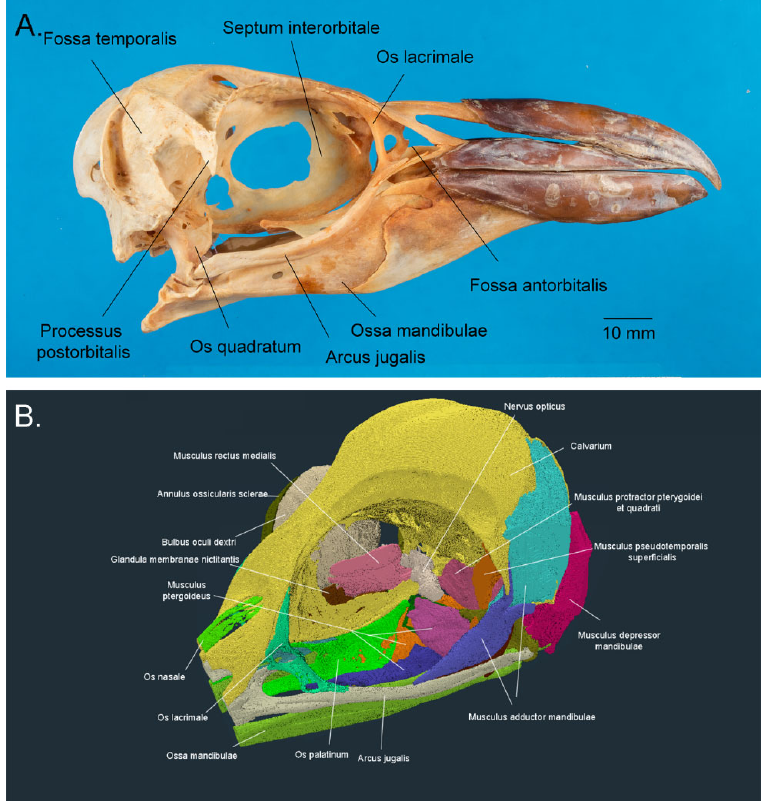
Figure 3. The orbit and ocular adnexae. ( A ) Skull of the Fiordland crested penguin Eudyptes pachyrhynchus , with the bony elements that border Orbita (the orbit) labelled (specimen AV1178, Otago Museum, Dunedin, New Zealand; Credit: Dane A. Gerneke, University of Auckland); ( B ) The orbital region of the little penguin Eudyptula minor , demonstrating the bones, muscles, and glands that surround Bulbus oculi (the eye). Reconstructed from publicly available raw data at https://figshare.com/search?q=10.17608/k6.auckland.c.5599341 accessed on 9 June 2022 (Digital Sci ‐ ence, London, UK) using Amira 2021.2 (Thermo Fisher Scientific, Waltham, MA, USA) software.